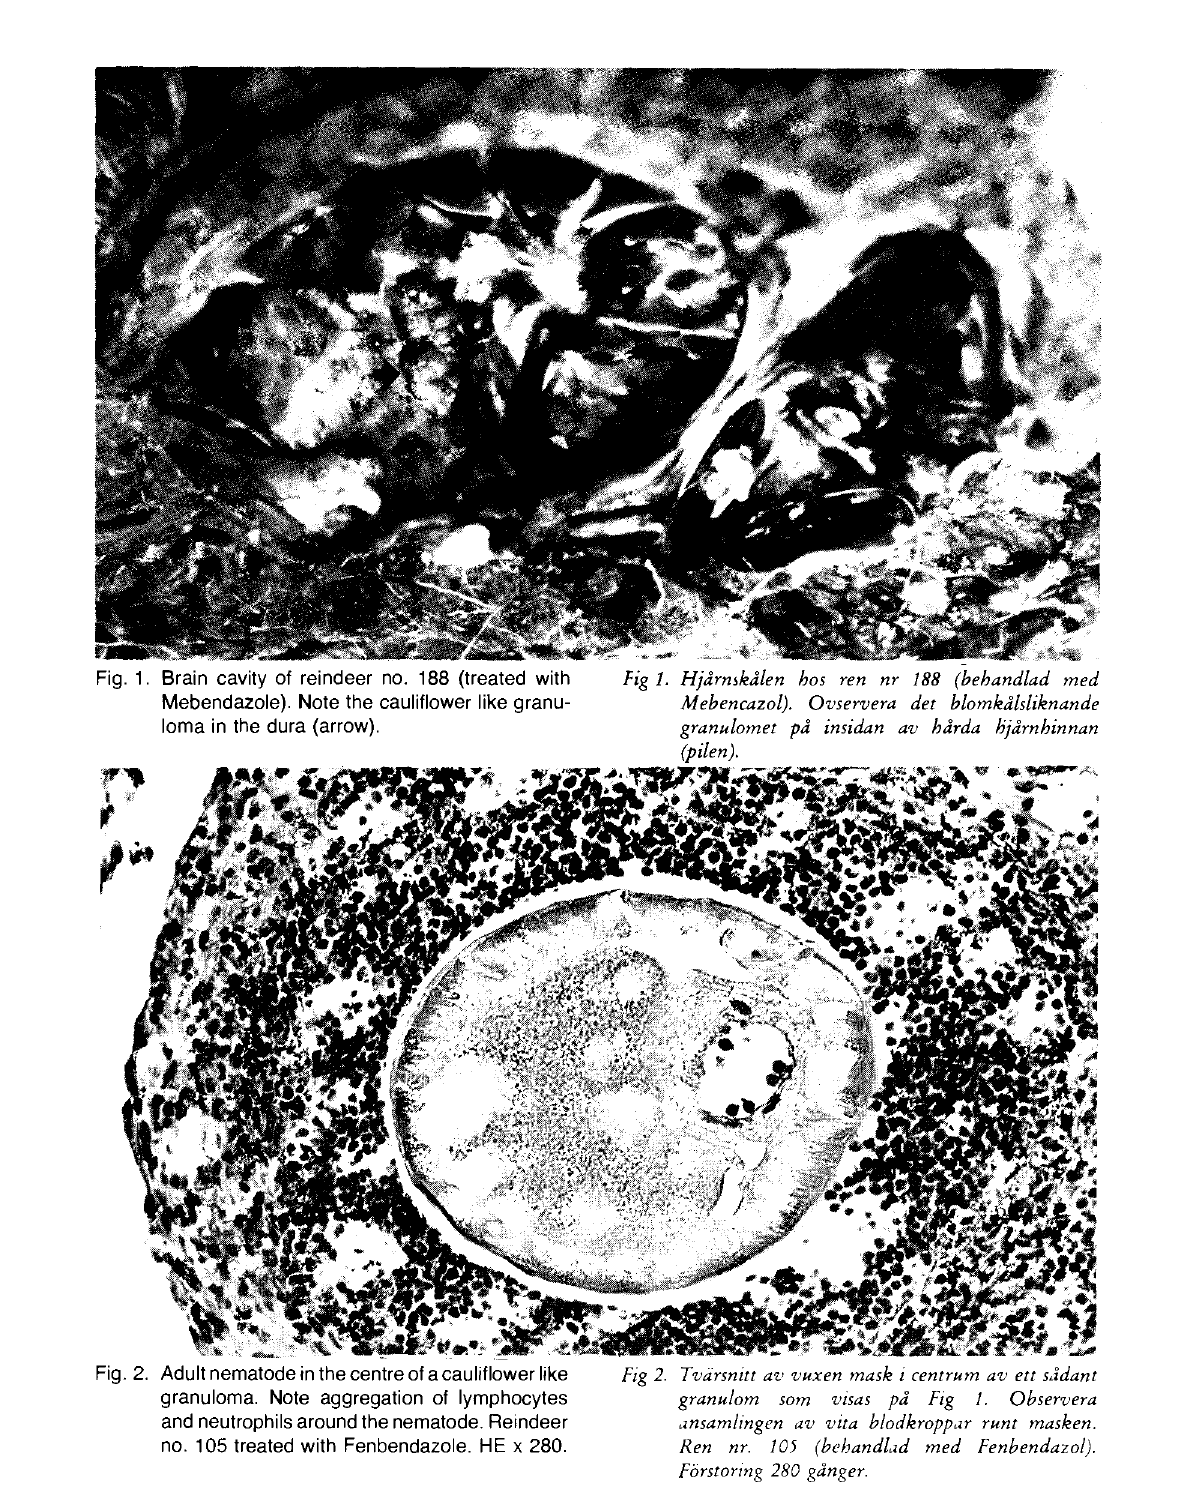
Fig. 2. Adult nematode in the centre of a cauliflower like Fig 2. Tvarsnitt av vuxen mask i centrum av ett sådant granuloma. Note aggregation of lymphocytes granulom som visas pd Fig 1. Observera and neutrophils around the nematode. Reindeer ansamlingen av vita blodkroppar runt masken. no. 105 treated with Fenbendazole. HE x 280. Ren nr. 105 (behandlad med Fenbendazol). Forstormg 280